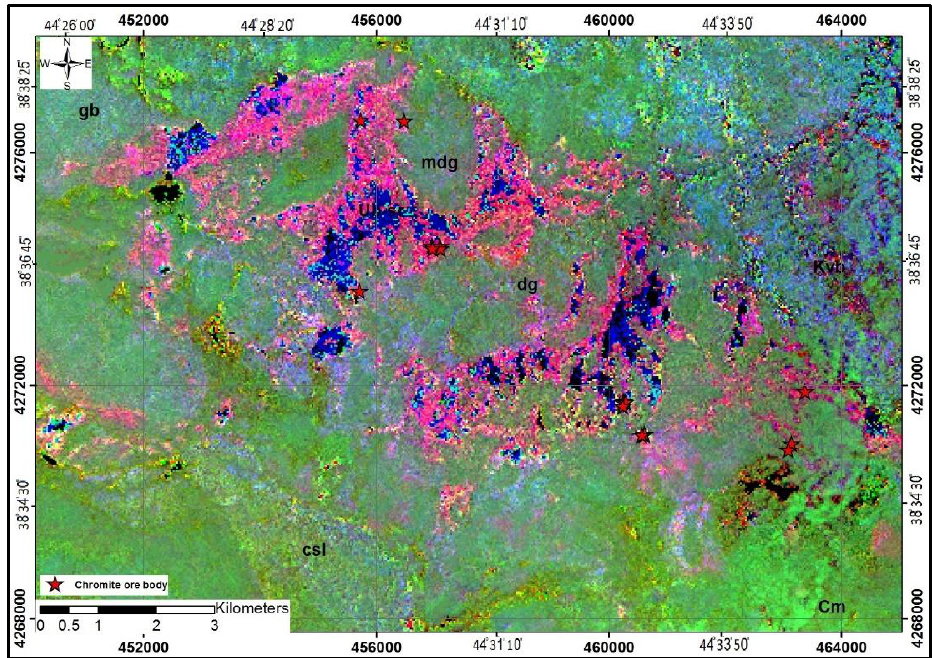
Figure 7. Harzburgite (with slight serpentinization) and highly serpentinized harzburgites (serpentinite) separation.